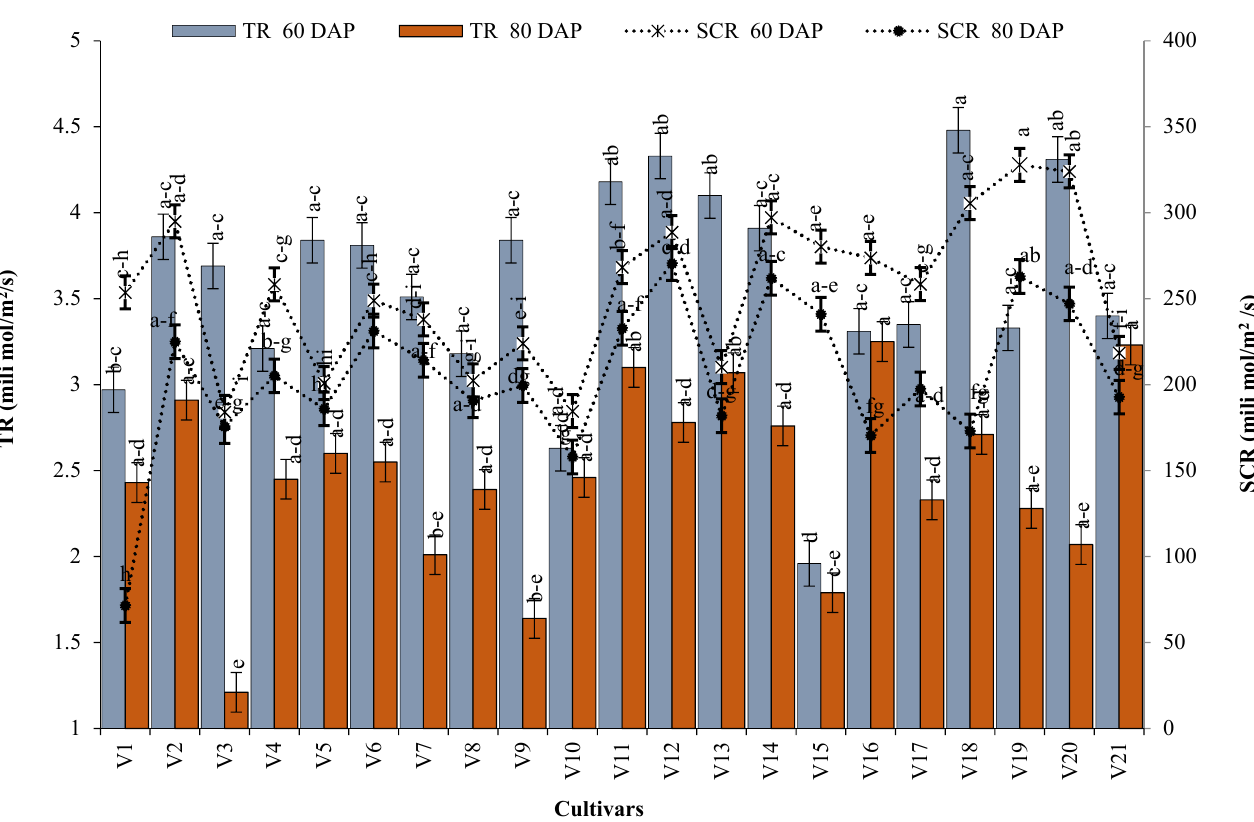
Figure 6. TR and SCR of different potato cultivars at 60 and 80 days after planting (estimation from two years pooled data); values with different lower case letters are significantly different between each other at the 5% level of significance ( p ≤ 0.05); vertical bars represent standard error of mean values.